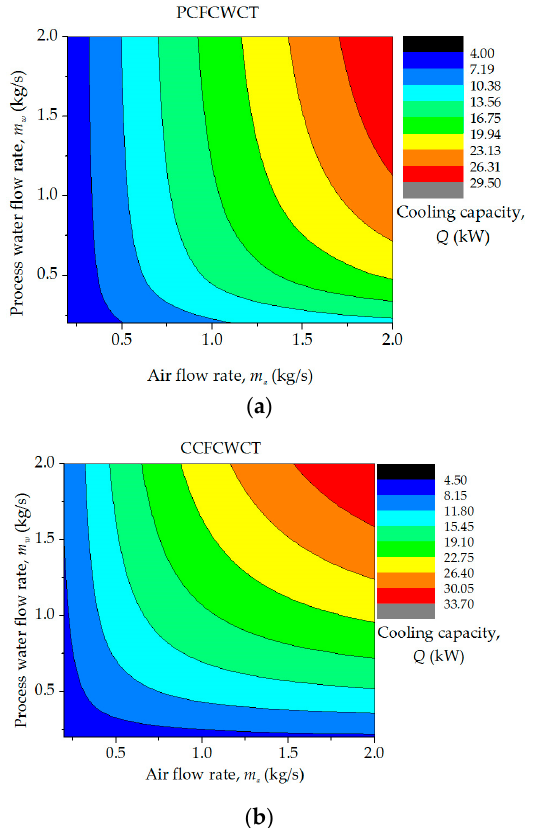
Figure 8. Cooling capacity of both towers versus different mass flow rates of process water and air: ( a ) PCFCWCT and ( b ) CCFCWCT.